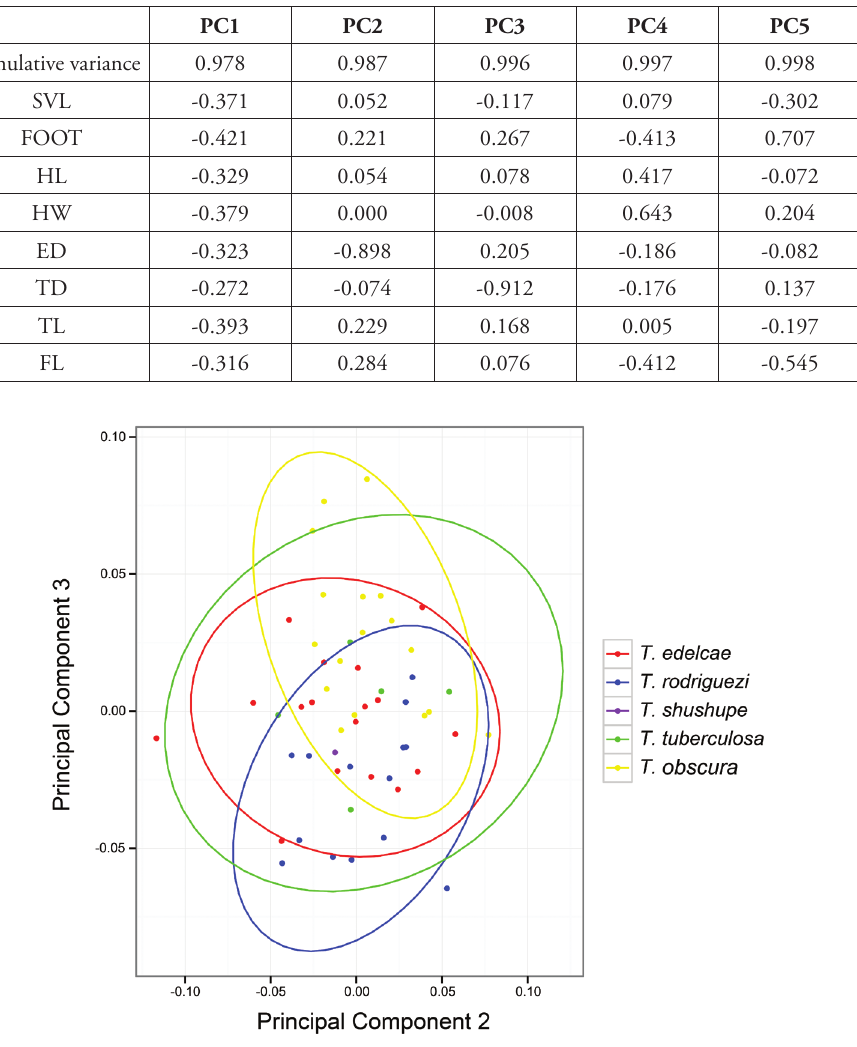
Figure 2. Principal Components 2 and 3 from analysis of eight morphological variables. See Table 2 for character loadings on each